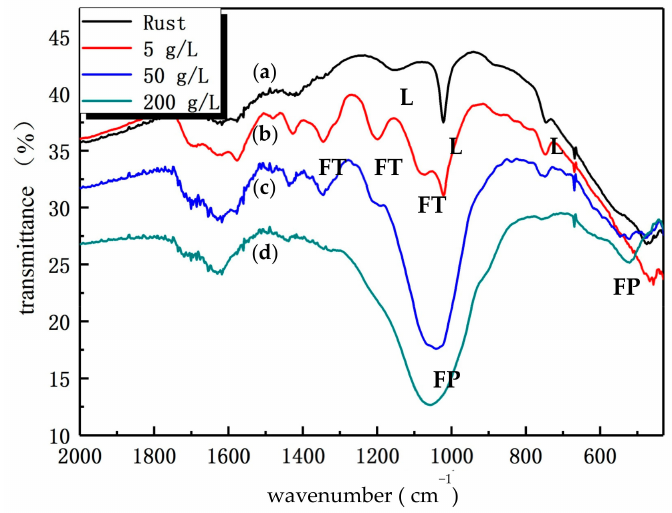
Figure 2. Infrared spectra for: ( a ) rust, after treatment with ( b ) 5 g/L, ( c ) 50 g/L, ( d ) 200 g/L phosphoric acid in conjunction with the tannic rust converter (L: lepidocrocite, FT: ferric tannate, FP: ferric phosphate).